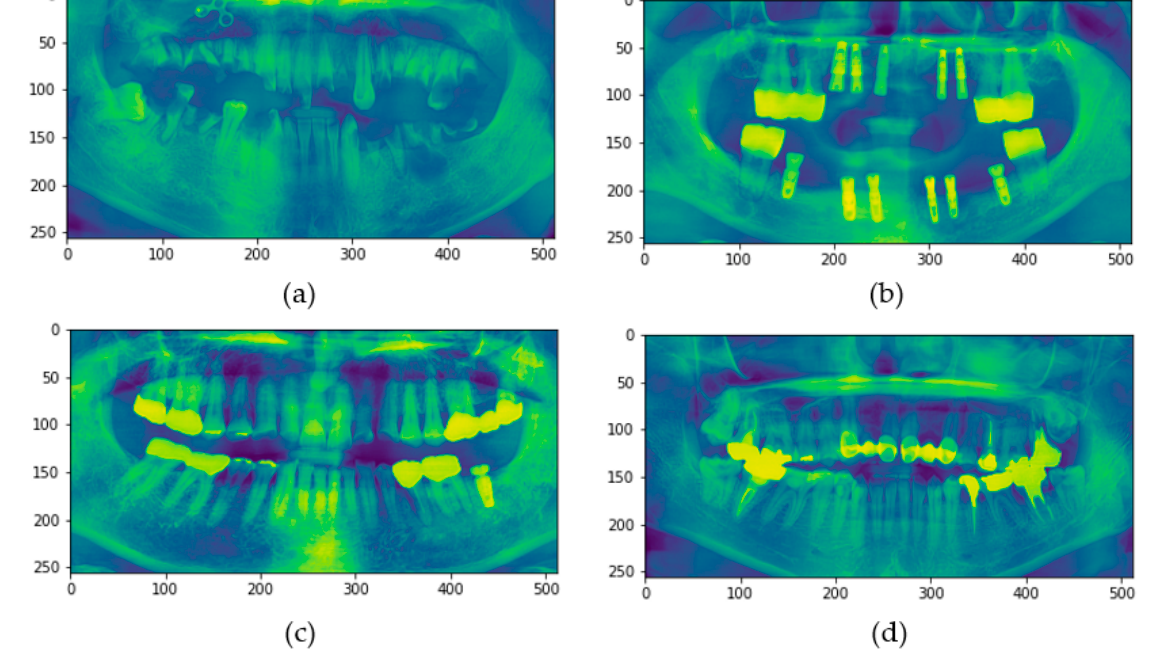
Figure 11. Dental radiographs of persons whose dental ages were misclassified by more than 25 years: ( a ) actual age is in the 20s, predicted dental age is 67.22; ( b ) actual age is in the 20s, predicted dental age is 69.52; ( c ) actual age is in the 20s, predicted dental age is 61.59; and ( d ) actual age is in the 20s, predicted dental age is